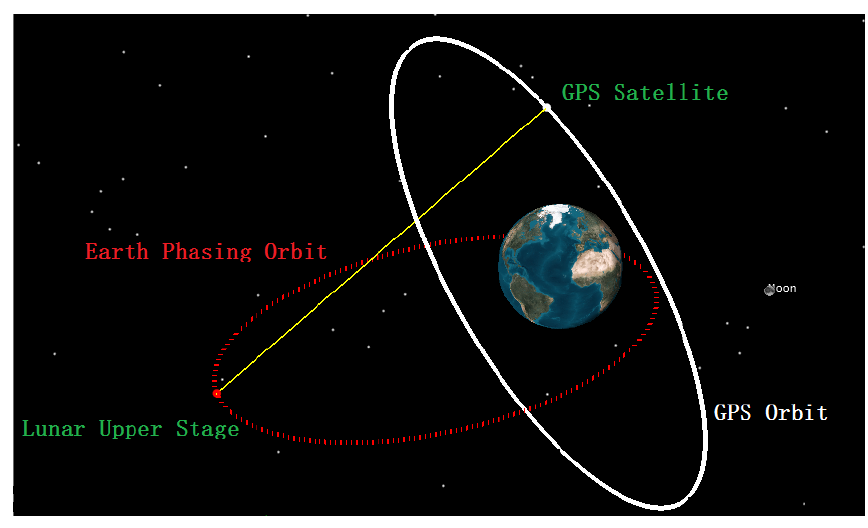
Figure 5. Schematic diagram of the simulation scenario. Table 2. The requirements of bearable dynamics for onboard GNSS receiver of the lunar probe.